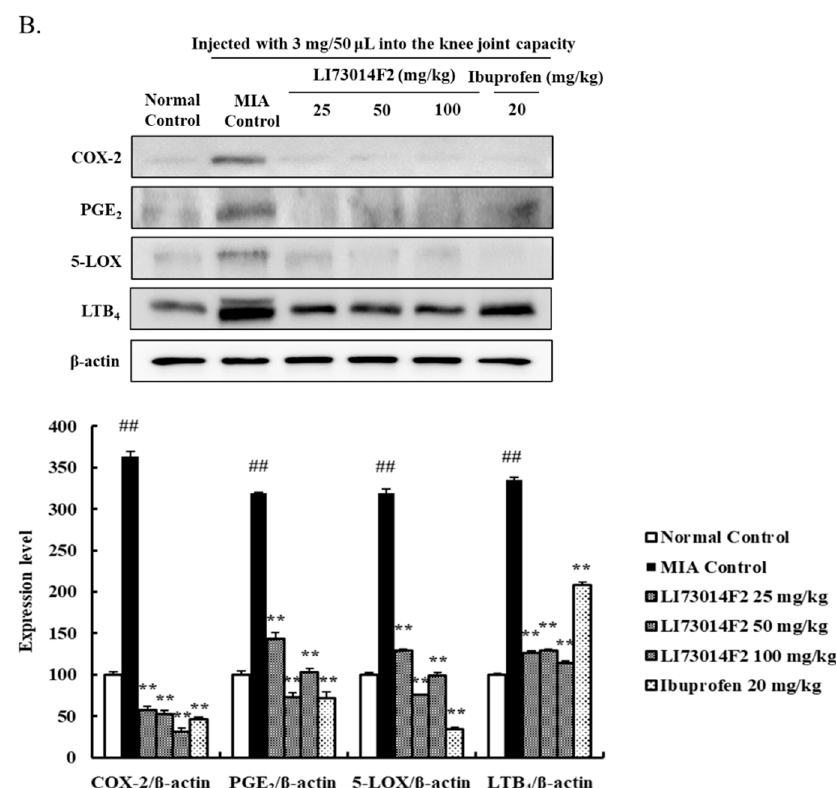
Figure 3. E ff ects of LI73014F2 on the expression levels of inflammation-related proteins in articular cartilage. The expression levels of ( A ) pro-inflammatory cytokines interleukin-1 β (IL-1 β ), IL-6, and tumor necrosis factor-alpha (TNF- α ), and ( B ) inflammatory mediators cyclooxygenase-2 (COX-2), prostaglandin E2 (PGE 2 ), 5-lipoxygenase (5-LOX), and leukotriene B 4 (LTB 4 ) were measured using Western blot analysis; density of the protein bands was quantified and calculated using ImageJ software. Protein expression levels were normalized to those of β -actin and are expressed as mean ± SEM of independent experiments ( n = 3 / group). ** p < 0.01, compared to the MIA-induced control group; ## p < 0.01, compared to the non-MIA-induced control group.